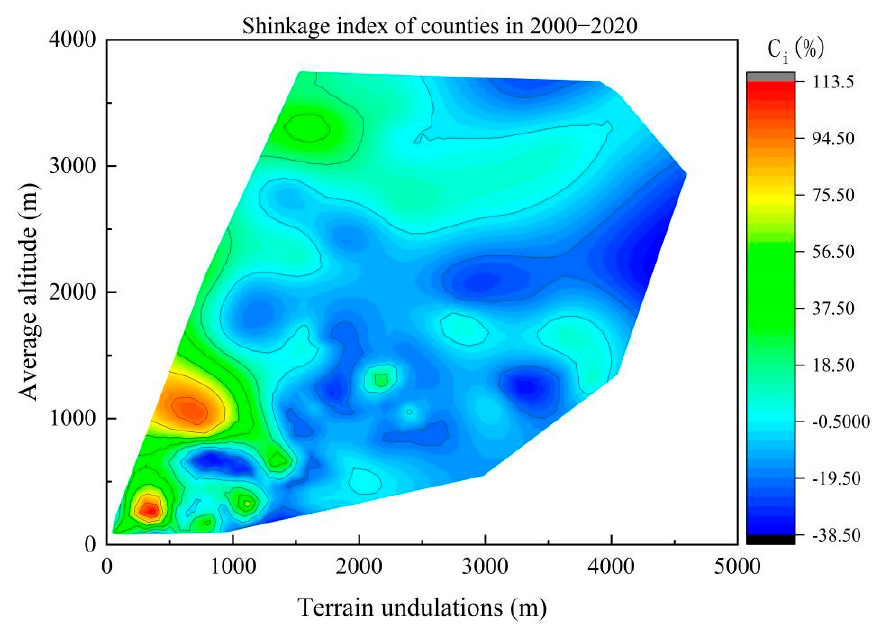
Figure 7. Contour map of county population shrinkage for the whole study period in the North − South Transitional Zone of China.